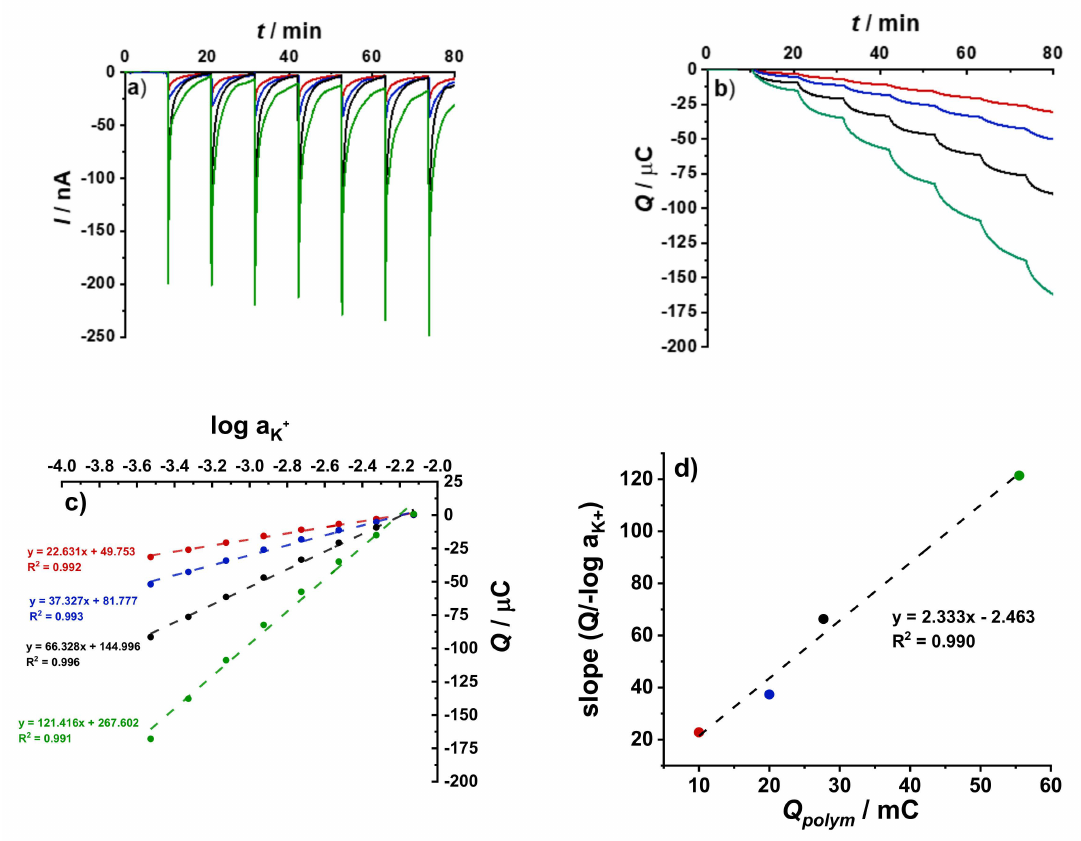
Figure 7. Chronoamperometric ( a ), chronocoulometric ( b ) response, cumulated charge Q vs. loga K+ ( c ) during the calibration conducted in 10 − 2 M to 10 − 3.4 M KCl + 10 − 1 M NaCl as BGE with ∆ log C K+ = 0.2 decade step − 1 ; 3 mm GC/10 mC PEDOT:PSS/DM (red), 3 mm GC/20 mC PEDOT:PSS/DM (blue), 5 mm GC/27.8 mC PEDOT:PSS/DM (black), or 5 mm GC/55.5 mC PE- DOT:PSS/DM (green) with equivalent dummy membrane thickness were used as WEs. GC/2 mC PEDOT:PSS/50 µ L K + - ISM and GC rod were connected as the RE and CE, respectively. Slope values from results in ( c ) against the polymerization charge Q polym of the PEDOT:PSS film in the WE ( d ). Similar results were obtained using a GC/10 µ L 0.5 wt% MWCNTs/50 µ L K + -